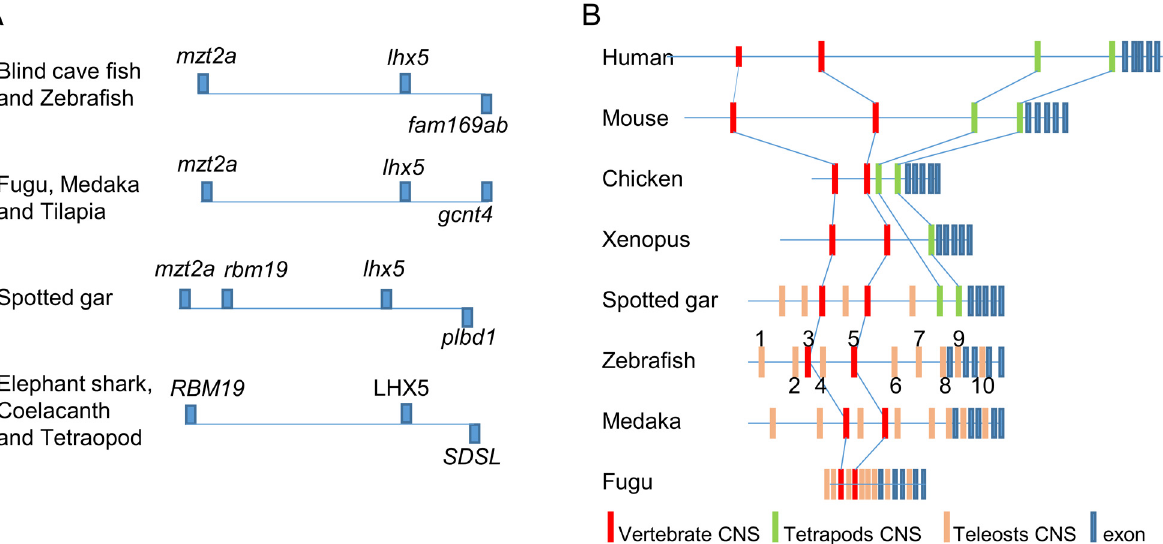
Fig 1. Schematic overview of the lhx5 locus. ( A ) Genomic regions surrounding lhx5 genes from vertebrate species. The teleost lhx5 gene is flanked by adjacent upstream gene mzt2b (Fugu, Medaka, Tilapia, cavefish and zebrafish). The cartilaginous elephant shark, the lobe-finned coelacanth, and the tetrapod species show the same rbm19 - lhx5 - sdsl gene co-localization. The spotted gar mzt2b - rbm19 - lhx5 gene co-localization is partially similar to both the tetrapod and the teleost fishes. ( B ) Conserved non-coding sequences (CNS) in the upstream genomic sequence of lhx5 locus in eight representative vertebrate species. Eight of the ten CNSs are teleost-specific, and two CNSs (CNS3 and CNS5) are found in all eight species.